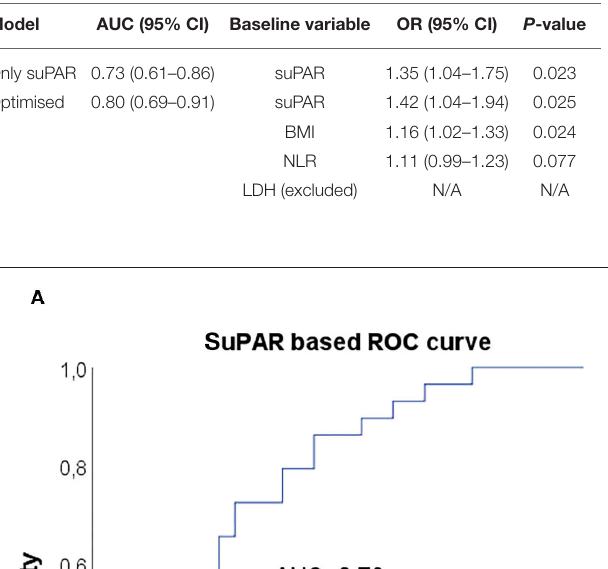
Frontiers in Medicine |